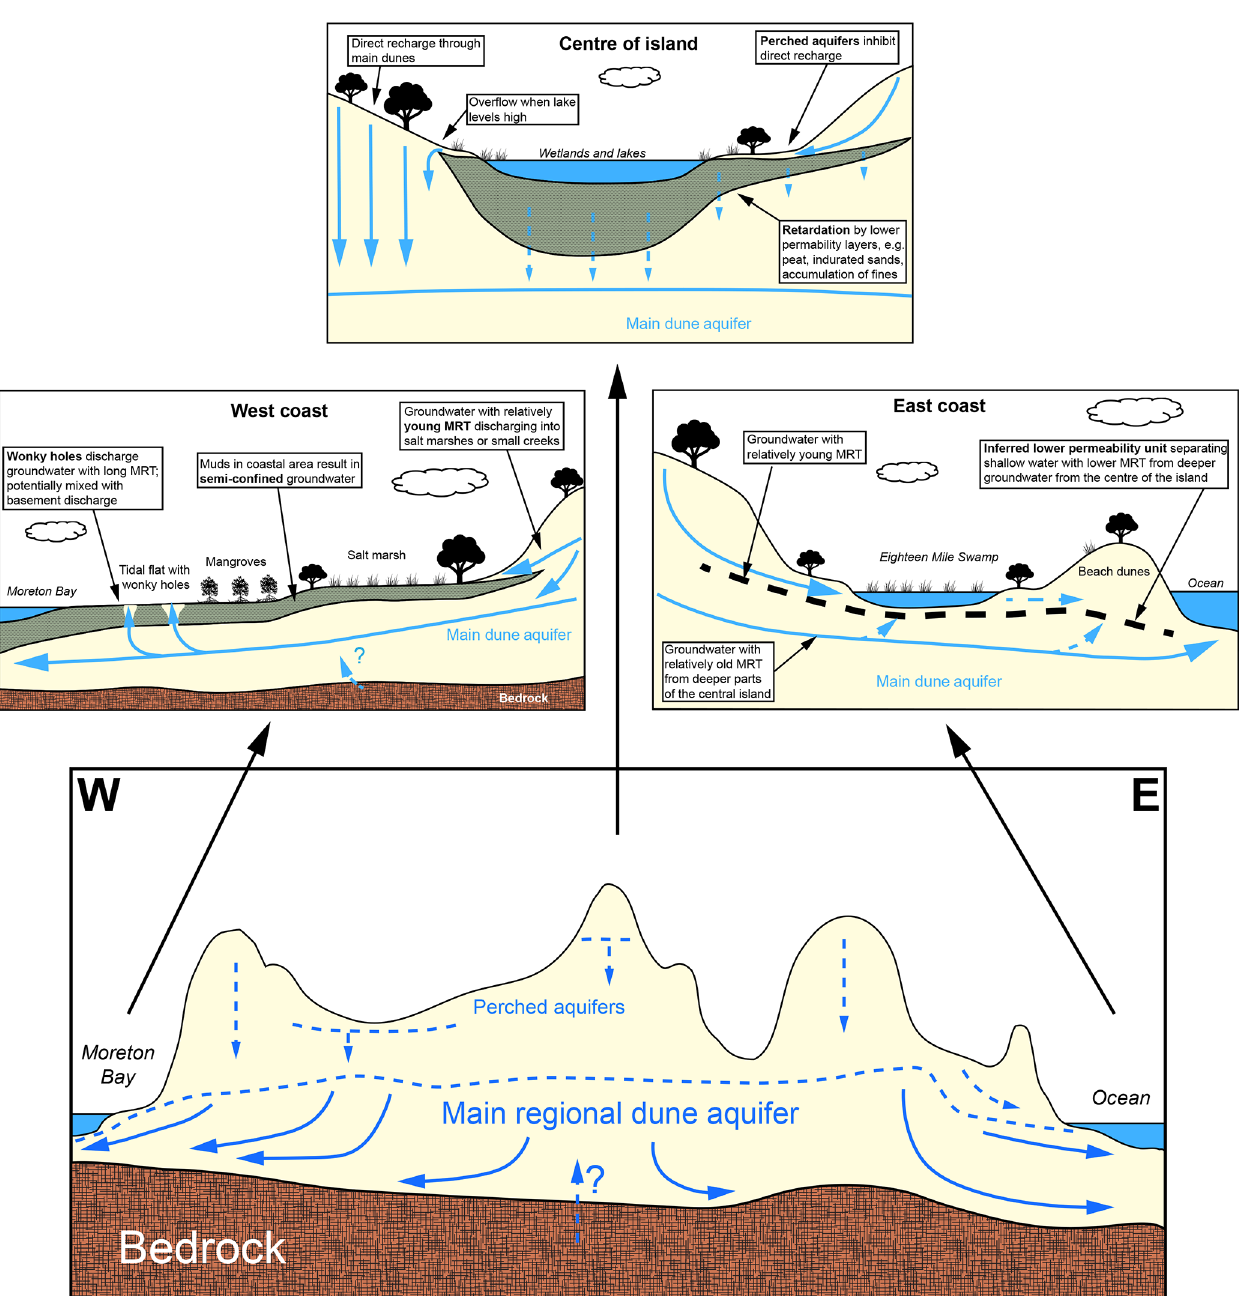
Figure 9. Conceptual sketch of groundwater flow across the island from the centre of the island to the ocean in the east and to Moreton Bay in the west. Parts of the centrally recharged groundwater also flow to the north and the south (Leach and Gallagher, 2013). Lower-permeability units in the unsaturated zone can have longer residence times than direct recharge. There may also be groundwater contributions from the bedrock. On the western side, some of the groundwater is discharged directly into Moreton Bay, while some flows underneath the tidal mud flats in semi-confined conditions and is discharged partly through wonky holes into the